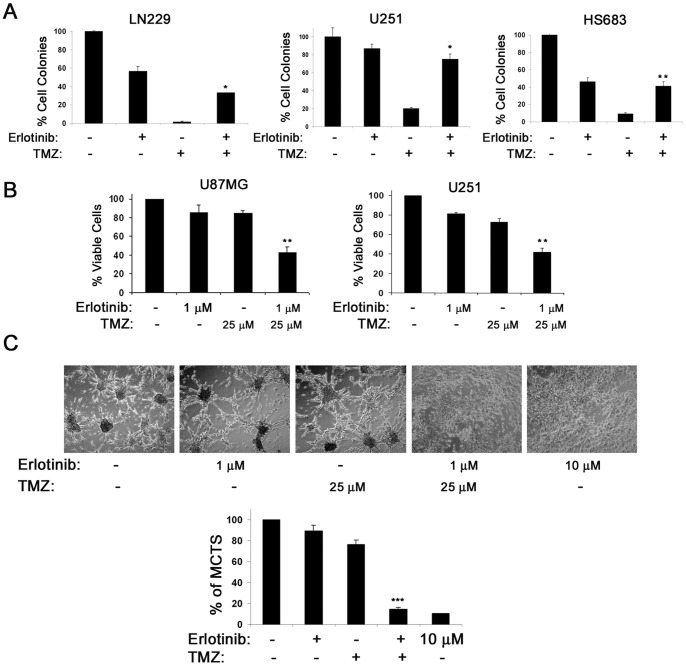
EGFR inhibition cooperates with temozolomide to inhibit glioma cell growth.(A) LN229, U251 and HS683 cells were left untreated or were treated for 24 h with erlotinib and subsequently exposed to vehicle or TMZ for 3 h, plated and after 7–10 days the remaining colonies were stained and counted as indicated in Materials and Methods. The mean ± SD values from three independent experiments, each conducted in duplicate, are shown in the graph, representing the number of clones relative to untreated cells. The differences between combined treatment and either treatment alone are statistically significant (Student's t-test: *P<0.05 and **P<0.01, respectively). (B) U251 and U87MG cells were plated in 96-well plates, left untreated or treated as indicated for 48 h and cell viability monitored as described in Materials and Methods. The mean ± SD values from three independent experiments, each conducted in duplicate, are shown in the graph, representing the percentage of viable cells relative to untreated cells. The differences between combined treatment and either treatment alone are statistically significant (Student's t-test: **P<0.01). (C) Representative phase-contrast micrographs of U87MG cells treated as indicated and left for 4–6 days to allow formation of MCTS. The graph indicates the mean ± SD values of MCTS formation from three independent experiments, each conducted in duplicate, expressed as the percentage of MCTS relative to untreated cells. The differences between combined treatment and either treatment alone are statistically significant (Student's t-test: ***P<0.001).